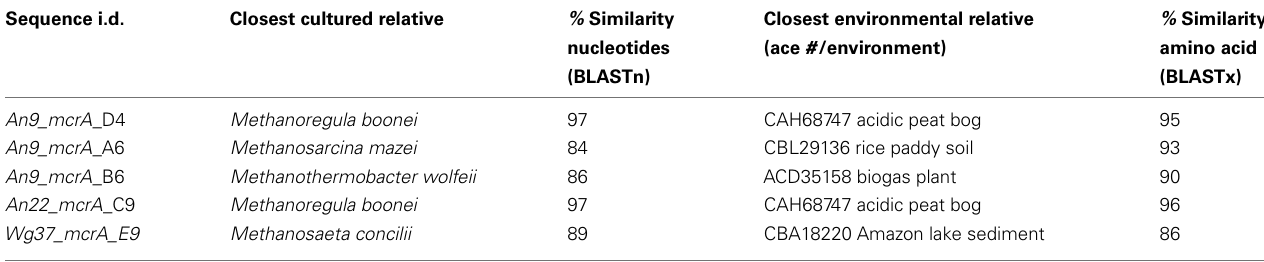
TableA1 | Summary of archaeal methyl coenzyme M reductase ( mcrA ) clone library results from the tank water of three bromeliads specimens. Sequence i.d.